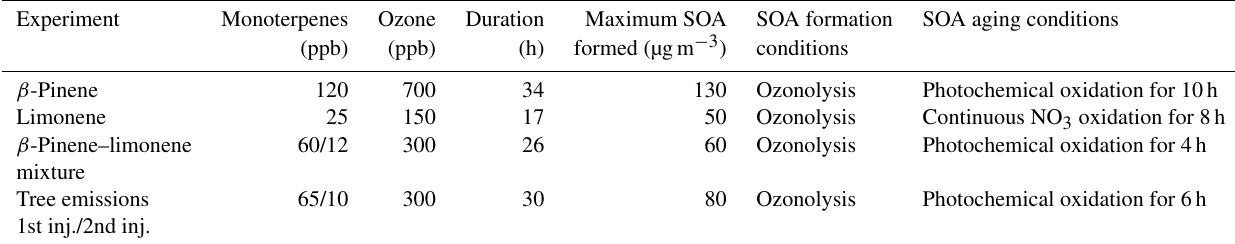
Table 1. Experimental conditions for each experiment. For the tree emissions experiment there were two VOC injection periods. Experiment Monoterpenes Ozone Duration Maximum SOA SOA formation SOA aging conditions (ppb) (ppb) (h) formed (µgm − 3 ) conditions β -Pinene 120 700 34 130 Ozonolysis Photochemical oxidation for 10h Limonene 25 150 17 50 Ozonolysis Continuous NO 3 oxidation for 8h β -Pinene–limonene 60/12 300 26 60 Ozonolysis Photochemical oxidation for 4h mixture Tree emissions 65/10 300 30 80 Ozonolysis Photochemical oxidation for 6h 1st inj./2nd